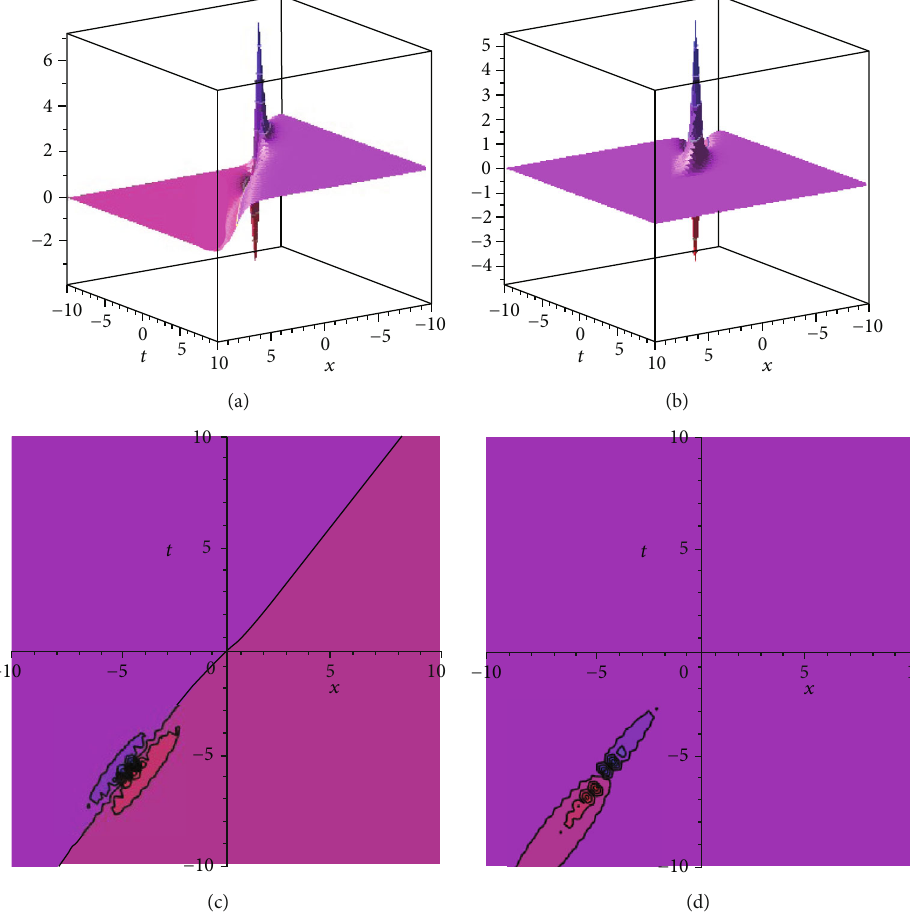
ð x , t Þ : (a) real three-dimensional shape, (b) complex three-dimensional shape, (c) 3